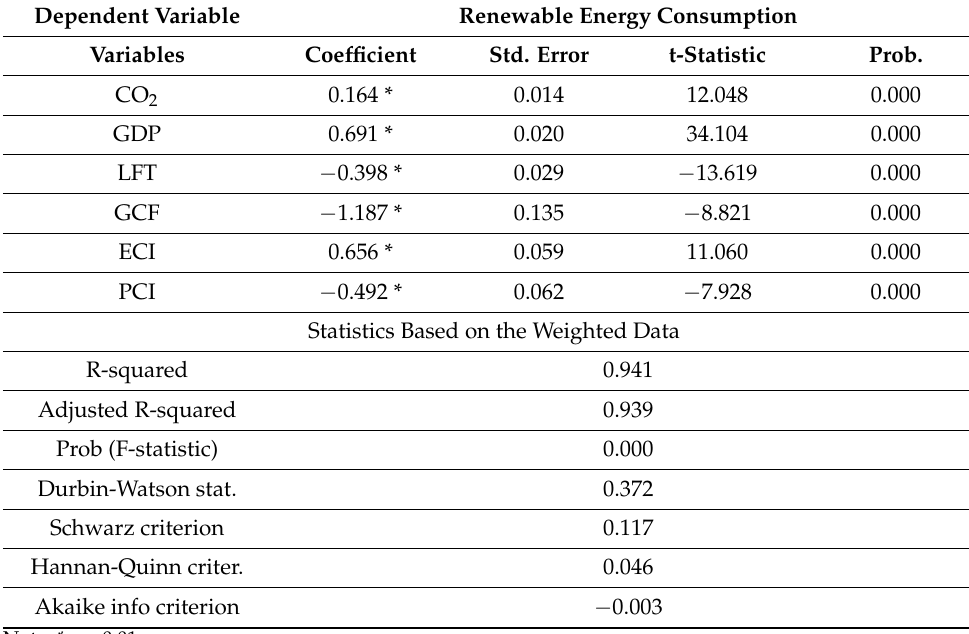
Table 9. Results of robustness